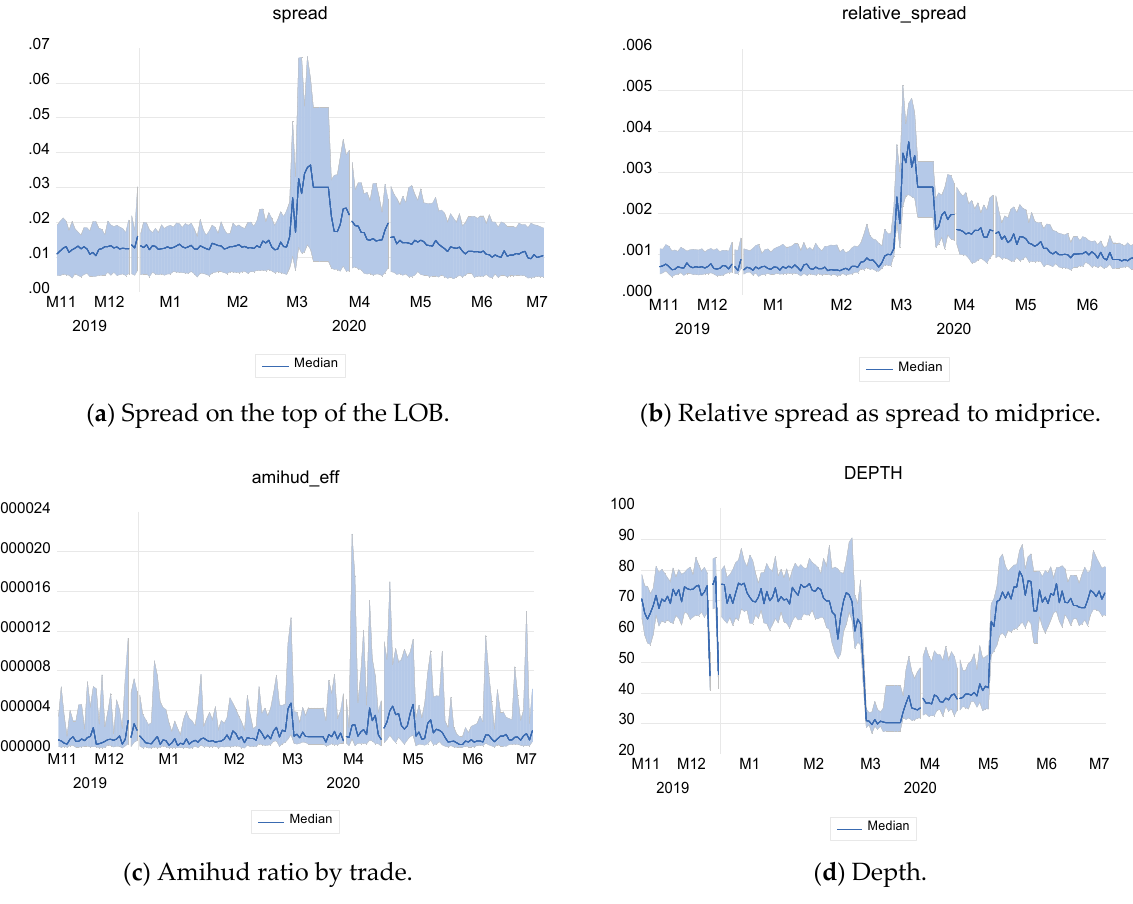
Figure 2. Liquidity measures during the periods under study. Medians and 1st and 4th quartile ranges are shown ( a ) Spread on the top of the LOB. ( b ) Relative spread as spread to midprice. ( c ) Amihud ratio by trade. ( d ) Depth of the complete level of the LOB.